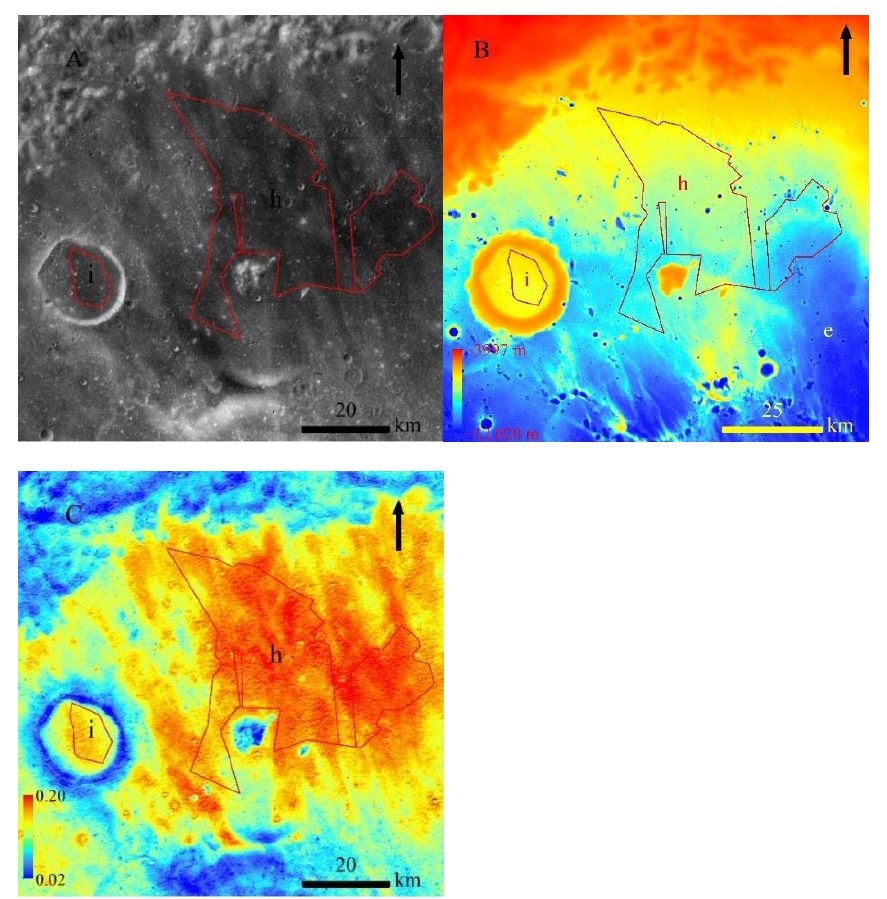
Figure 9. ( A ) CE-2 DOM mosaic (central location: 178.91° E, 36.23° S) of the mapped basalt units ‘ h ’ (1,450 km 2 ) and ‘ i ’ (127 km 2 ) in Leibnitz and Leibnitz X craters. The central peak and clustered secondaries are excluded in the counting area. ( B ) Local topography shown in SLDEM, and the elevation ranges from − 12,020 m to − 3,997 m as coded from blue to red in this figure. ( C ) FeO content map [24] of the counting areas, and the values range from 2.27% to 19.69% as coded from blue to red in this figure. The red polygons in each sub-figure are the outlined representative crater count areas. North is up in all sub-figures.